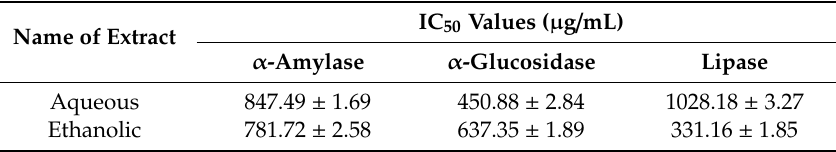
Figure 3. Bar chart showing the inhibition of the pancreatic lipase by aqueous and ethanolic extracts of Vernonia mespilifolia . The values in the bar chart are expressed as mean (lipase inhibition) ± SD (n = 5). Mean separation was done by LSD ( p < 0.05). Sets of bars (the same concentration) with different alphabets are significantly different; p < 0.05. # Less than the Orlistat (positive control). Table 1. Inhibitory potential (Half-maximal inhibitory concentration (IC 50 ) values) of aqueous and ethanolic extracts of Vernonia mespilifolia.